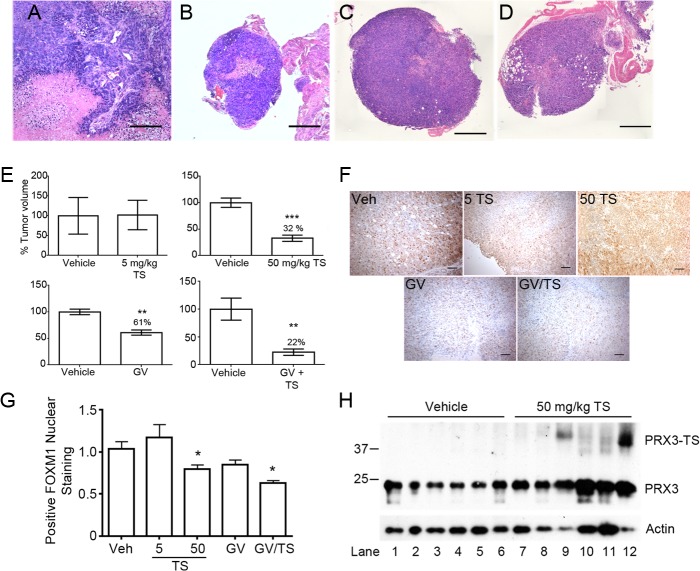
TS and gentian violet reduce tumor volume in a SCID mouse xenograft model of MM.(A) Hematoxylin and eosin (H&E) stained tumor tissue isolated from the peritoneal cavity of a DMSO control Fox Chase SCID mouse 5 weeks after injection of human HM cells. MM tumors were of biphasic morphology with necrotic areas that stained with eosin (pink staining). Tumors often contained stromal tissue of mouse origin and locally invaded the pancreas, liver and omentum. (B-D) Representative H & E stained tumor tissue from mice treated with 50 mg/kg TS, 2 mg/kg GV, or 5 mg/kg TS plus 2 mg/kg GV, respectively, every other day for 21–25 days. Tumor architecture and morphology was similar between treated and untreated animals (scale bar = 0.5 mm). (E) Tumor volumes from animals treated with 5 mg/kg TS, 50 mg/kg TS, 2mg/kg GV, or 2 mg/kg GV plus 5 mg/kg TS are presented as percent of vehicle control (DMSO) (n = 4–6 animals per group, ** p < 0.01, *** p < 0.001). (F) Representative images of FOXM1 immunohistochemistry used for nuclear quantification of FOXM1 from indicated tumor tissue (scale bar = 100 μm). (G) Quantification of FOXM1 positive nuclei from indicated treated tumor sections expressed as relative to vehicle (Veh) (n = 5, * p < 0.05). (H) Immunoblot of PRX3 expression in HM tumor lysates after reducing SDS-PAGE. Error bars represent SEM. See also S5 Fig.